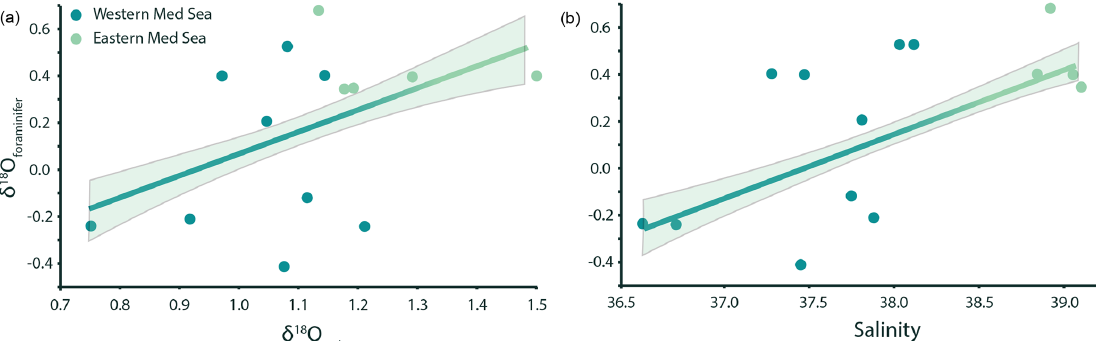
Figure 3. G. ruber albus δ 18 O measurements are positively correlated ( p value < 0.001) with both seawater δ 18 O (a) and salinity (b) . The relationships can be described using the following equations: δ 18 O foraminifer = 0 . 28 × S − 10 . 59 (adjusted R 2 = 0 . 42) and δ 18 O foraminifer = 0 . 95 × δ 18 O water − 0 . 89 (adjusted R 2 = 0 . 24). The relationship between δ 18 O water and salinity in this subset of samples is linear and com- parable to that of the entire dataset ( δ 18 O water = 0 . 13 × S − 3 . 91; p value < 0.05, R 2 = 0 .